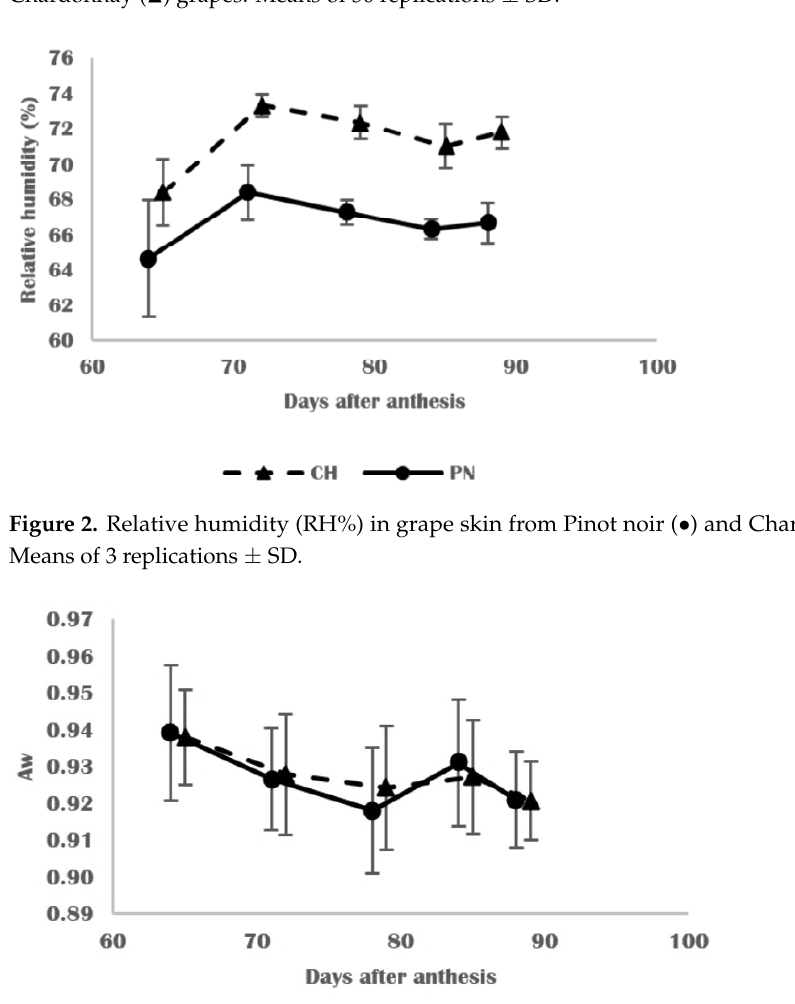
Figure 1. Penetrometry measurements expressed in force (g) for grape skin from Pinot noir ( • ) and Chardonnay ( (cid:78) ) grapes. Means of 30 replications ± SD.